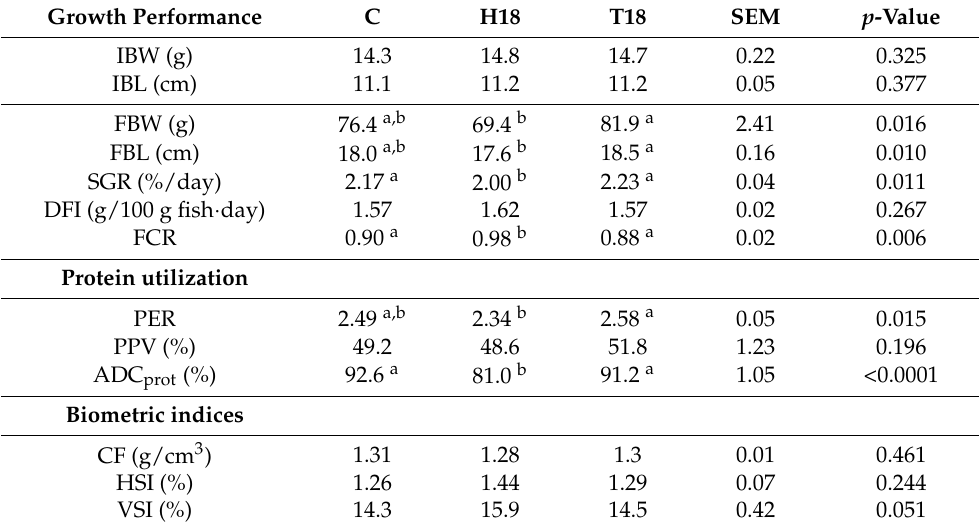
Table 3. Growth performance, protein utilization, and biometric indices of rainbow trout fed experi- mental